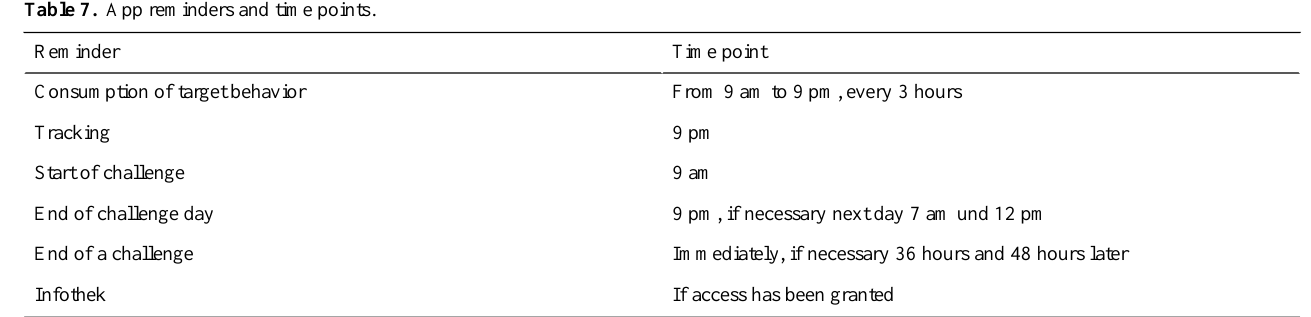
Table 7. App reminders and time